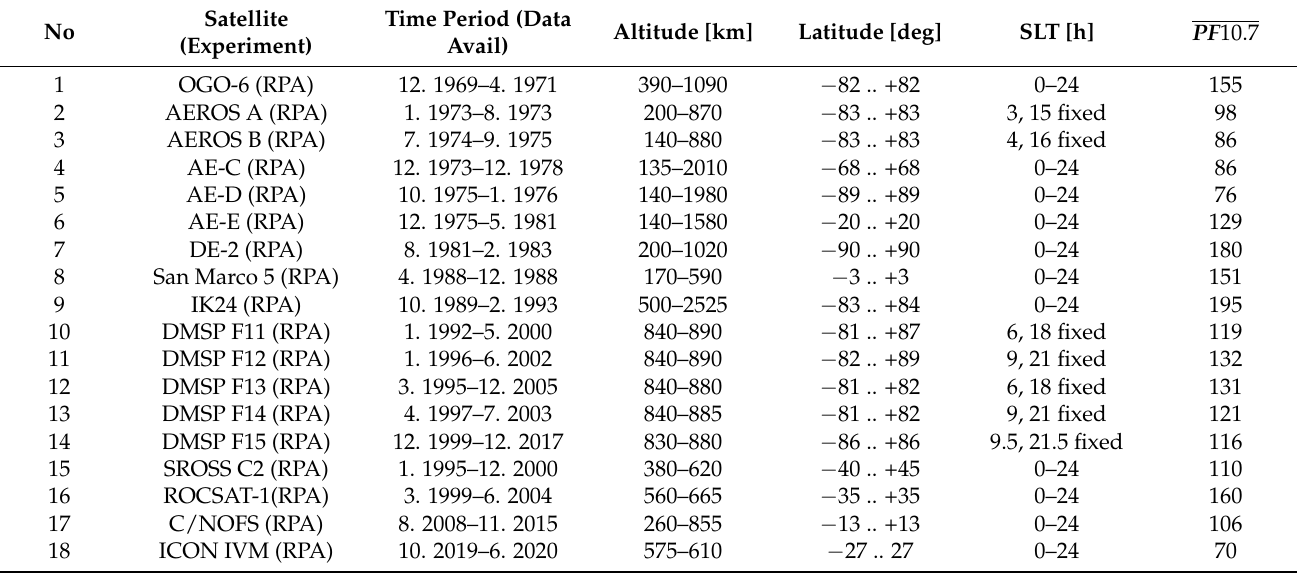
Table 1. A list of the satellites and experiments included in the database and their corresponding time intervals, altitude, latitude, and solar local time (SLT) ranges, and the average PF10.7